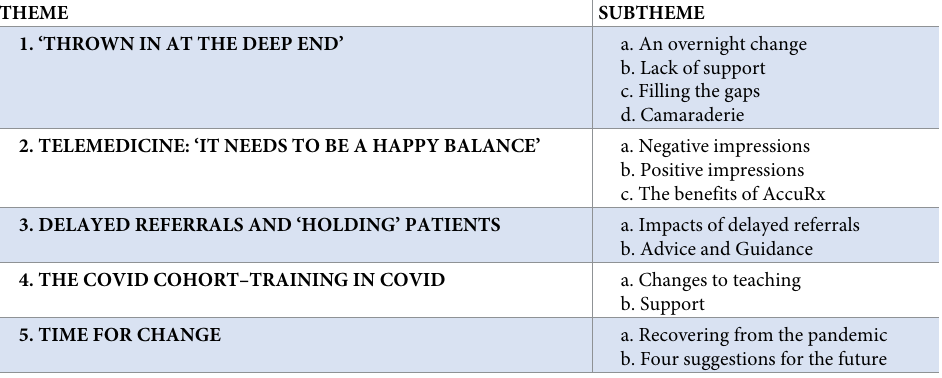
Table 4. Themes and subthemes. As identified in thematic